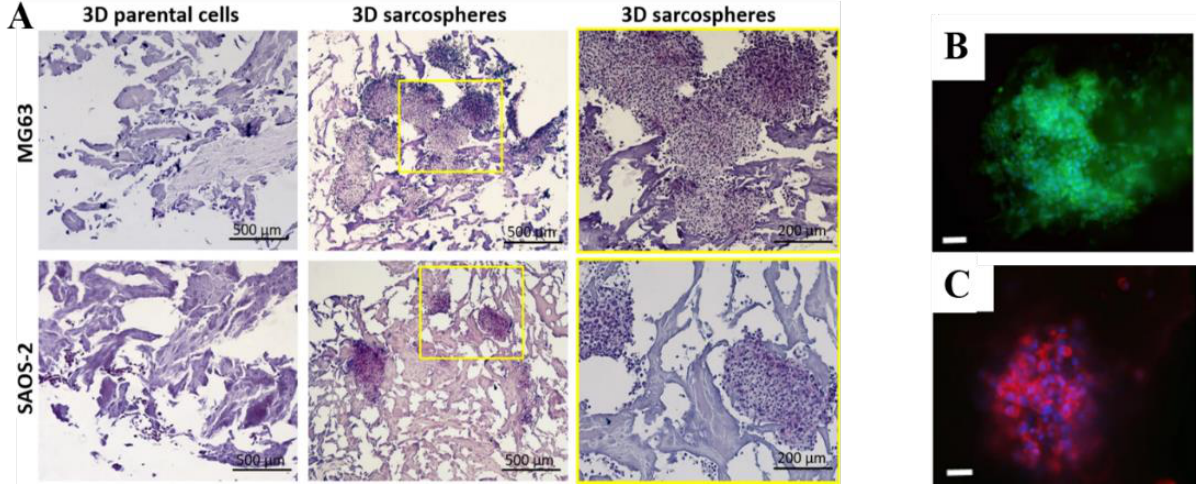
Figure 4. Panel of figures of in vitro 3D model of Cancer Stem Cells (CSCs)-niche of osteosarcoma from [73]. ( Under a Creative Commons Attribution 4.0 International License ) using biomineralized scaffolds based on collagen and magnesium-doped hydroxyapatite (MgHA/Coll scaffold) as bone-like ExtraCellular Matrix (ECM). ( A ) Histological analysis after Haematoxylin – Eosin (H&E) staining of the MgHA/Coll scaffold seeded with both cellular phenotypes, parental and spheroidal, of MG63 and SAOS-2 osteosarcoma cell lines. The morphological features and the interaction behavior of the sarcospheres and parental cells with the scaffold is shown, with image enlargements of 200 µm on the right of the figure. ( B , C ) Immunofluorescence analysis of the 3D MgHA/Coll models with sarcospheres. Representative image of OCT-4 immunolocalization in SAOS-2 sarcospheres in image ( B ) ; scale bar 50 µm. SOX-2 immunolocalization in MG63 sarcospheres in image ( C ); scale bar 25 µm. Blue DAPI: cell nuclei; green: OCT-4; and red: SOX-2.